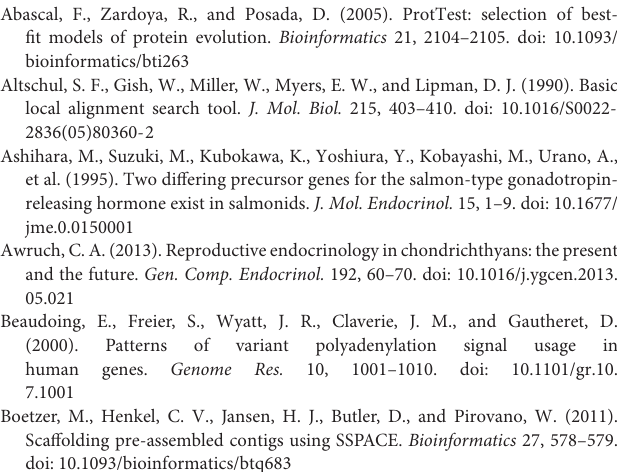
TABLE S1 | Sequences of the oligonucleotides used for PCR amplifications. TABLE S2 | Pair-wise comparison of full-length GnRH protein sequences from catshark, Scyliorhinus canicula, whale shark, Rhincodon typus, and elephant shark, Callorhinchus milii . Values represent percentage of amino acid identity. TABLE S3 | Chromosomal locations of gene orthologs in the synteny analysis of the GnRH loci. All human gene names in the table are approved HGNC symbols and the genes from other species have been given the name of their human orthologs. Chromosomal locations of genes are expressed in bp. Blanks represent genes that have not been found in the current genome databases. Non-syntenic genes are in gray. TABLE S4 | Primary structure of GnRH isoforms in vertebrates. Conserved residues are boxed. Amino acids changed compared with chicken GnRH2 are